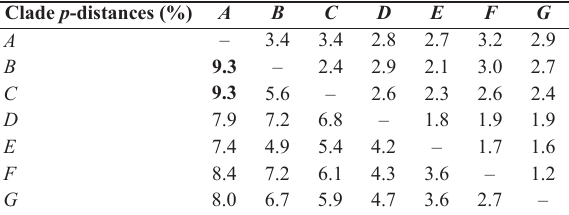
Table 2. Uncorrected genetic distances (%) between investi- gated tRNAGly-ND3 clades of the Duttaphrynus melanostictus complex as shown in the Fig. 1C. Given are p-distance values (lower-left) and standard error estimates